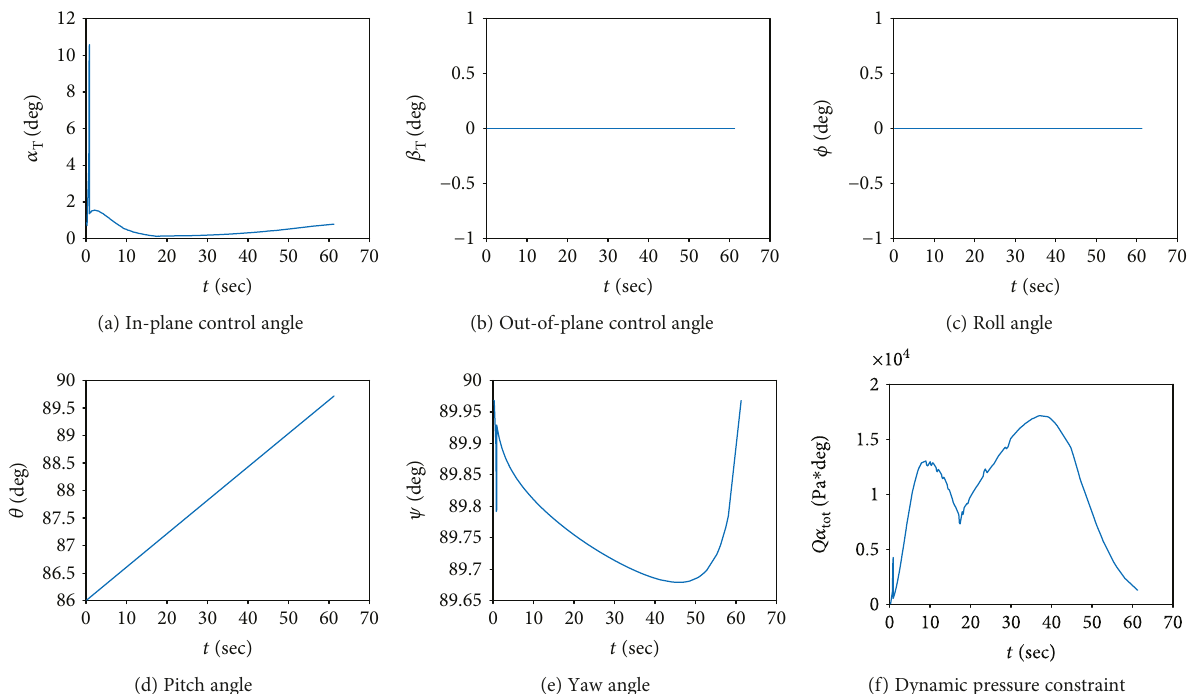
Figure 13: Control law, attitude angles, and dynamic pressure in the thrust arc for the con fi guration with l =7.29m and d =0.36m (near radial guidance).